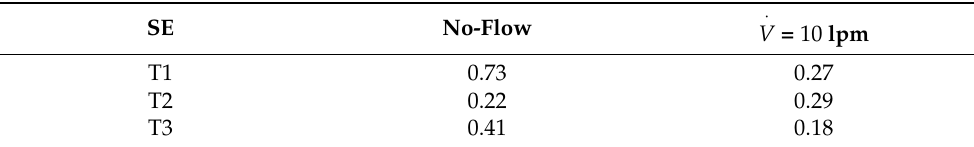
Figure 5. Local temperature validation under ( a ) no-flow condition and ( b ) He-cooling with · V = 10 L / min . Table 2. Standard error of